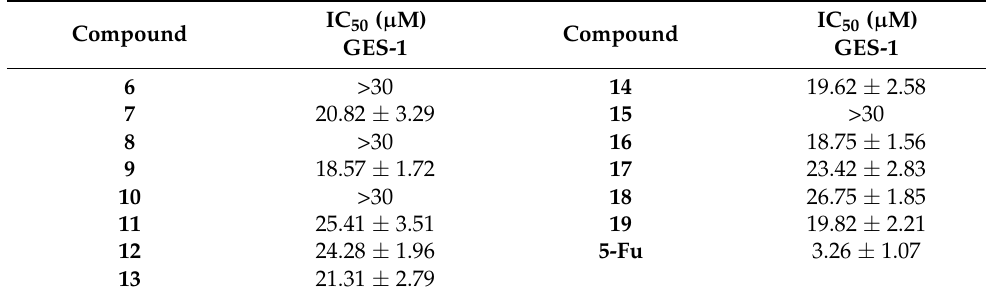
Table 2. Inhibitory activity of compounds 6 – 19 toward